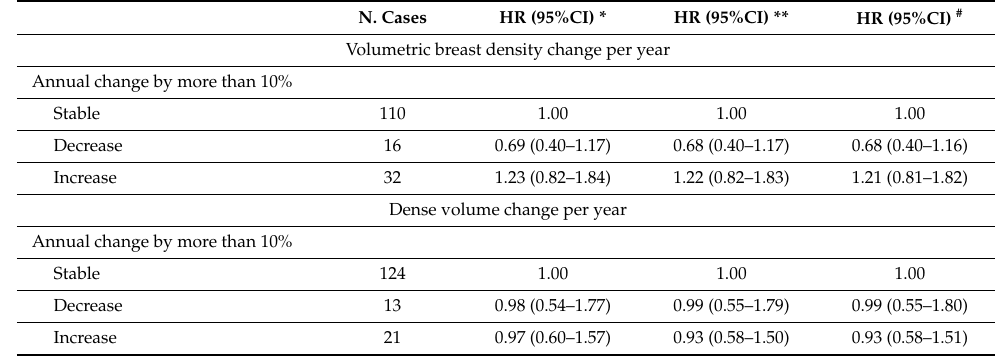
Table 3. Hazard ratios (HRs) and 95% confidence intervals (CI) of breast cancer risk in relation to changes in mammographic density measures in the FEDRA study (158 breast cancer cases with 2 or more FFDM out of 262; 12,633 repeated FFDM from non-cases out of 18,677). N.